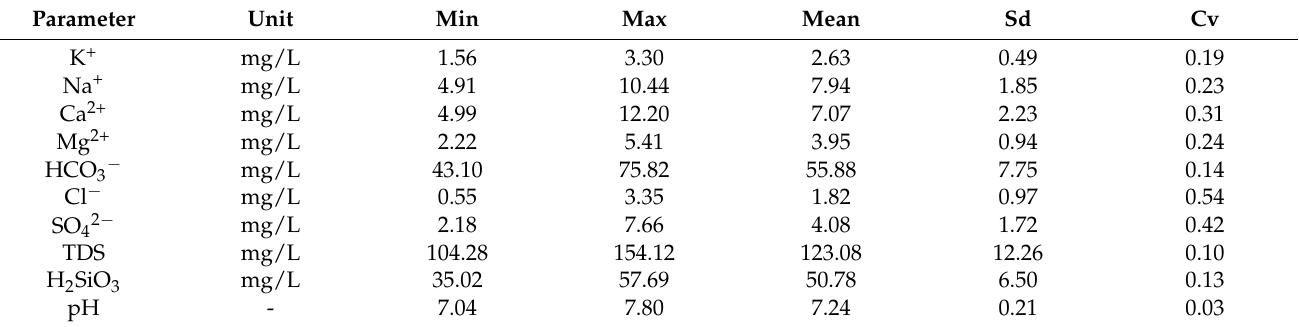
Table 1. Analytical results of stable hydrogen and oxygen isotope of water samples in study